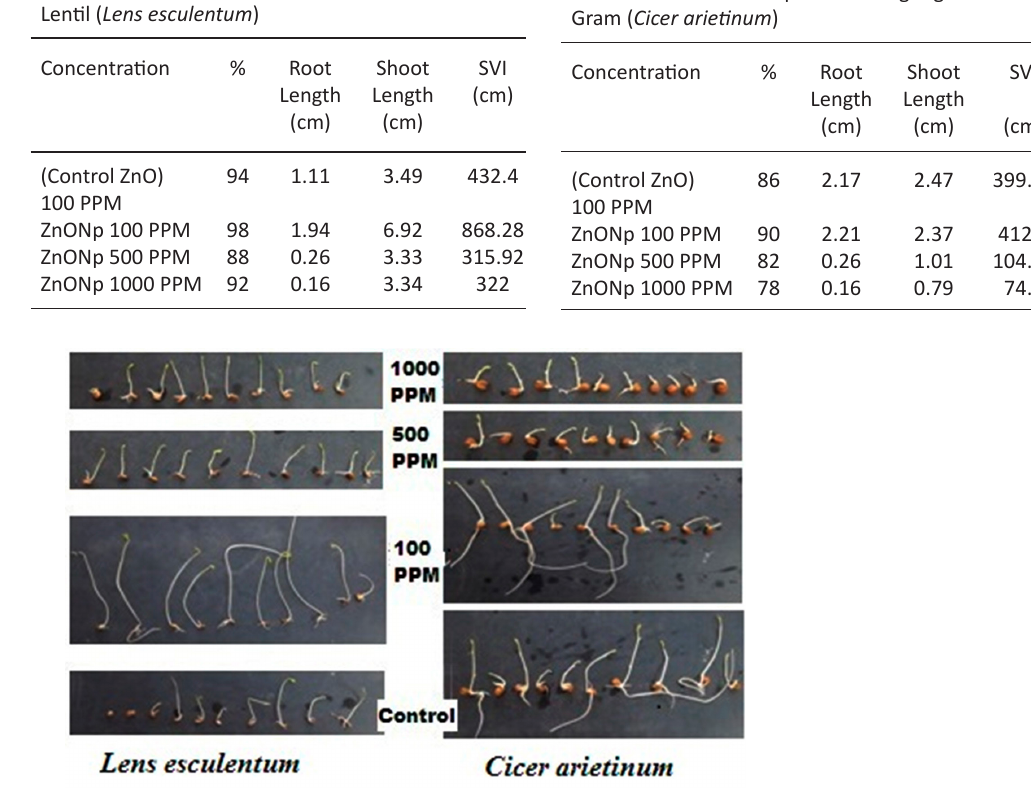
Table 8. Effect of ZnONp on Seedling Vigour Index of